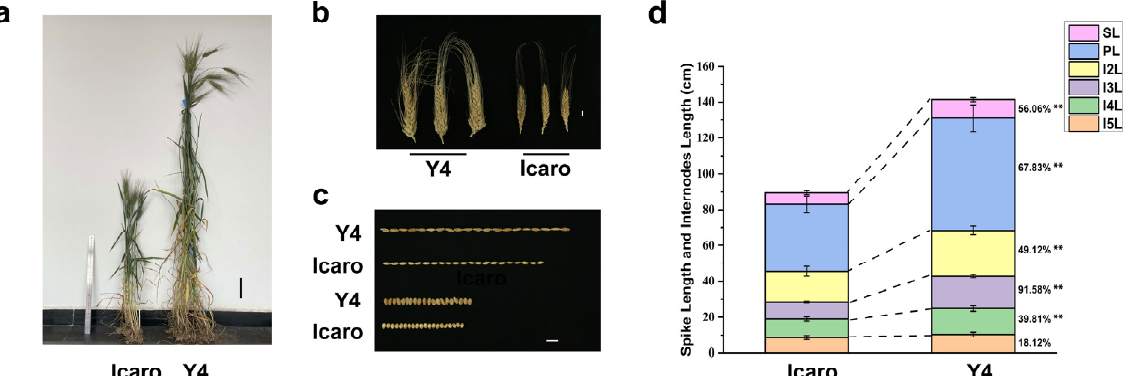
Figure 1. Phenotypic characteristics of the parent ‘Icaro’ and ‘Y4 ′ . ( a ) Plant height phenotype. The black line represents the scale = 10 cm. ( b ) Spike characteristics. Scale bar = 1 cm. ( c ) Kernel phenotypes. Scale bar = 1 cm. ( d ) Spike length and internodes length. SL, spike length; PL, peduncle length; I2L, I3L, I4L, and I5L represent the length of the second, third, fourth, and fifth internode from the top, respectively. ** significant at the level of p < 0.01.